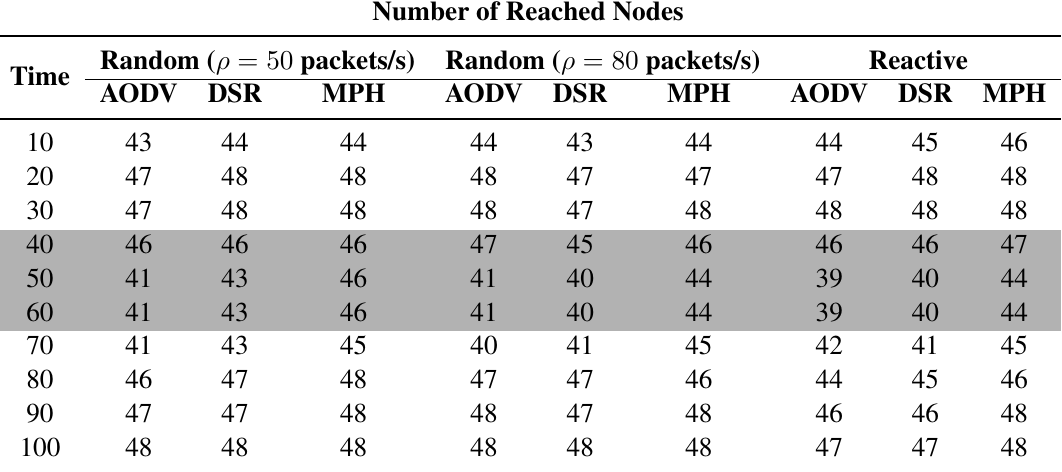
Table 5. Number of reached nodes by the coordinator when the jammer node is near.